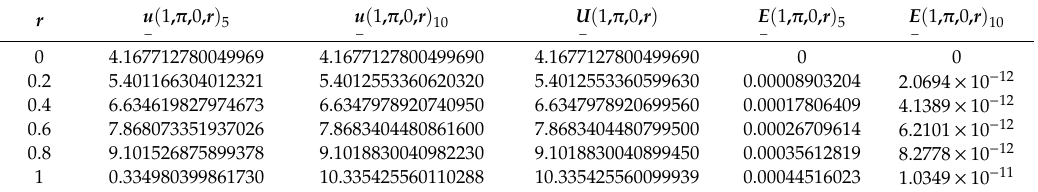
Table 7. Solution and accuracy of fifth and tenth order double parametric fuzzy HPM solutions for Equation (32) at t = π , x = 1 and b = 0 for all r ∈ [ 0,1 ] .